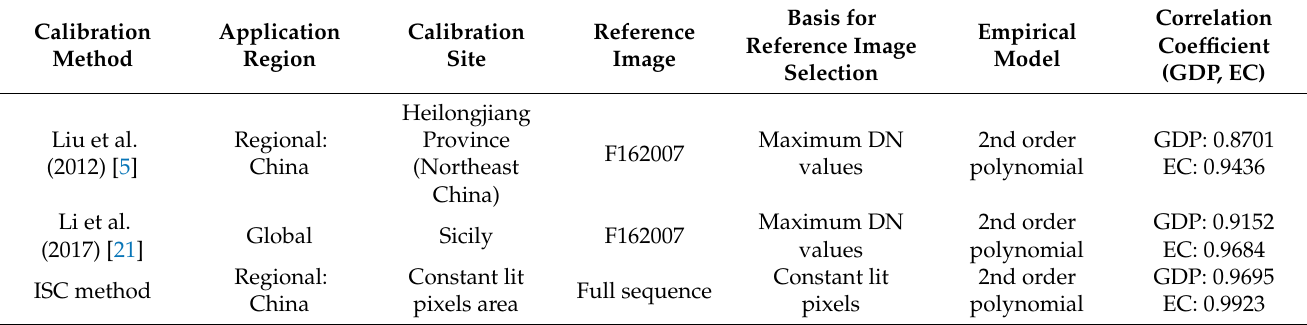
Table 1. Comparative analysis of three different calibration